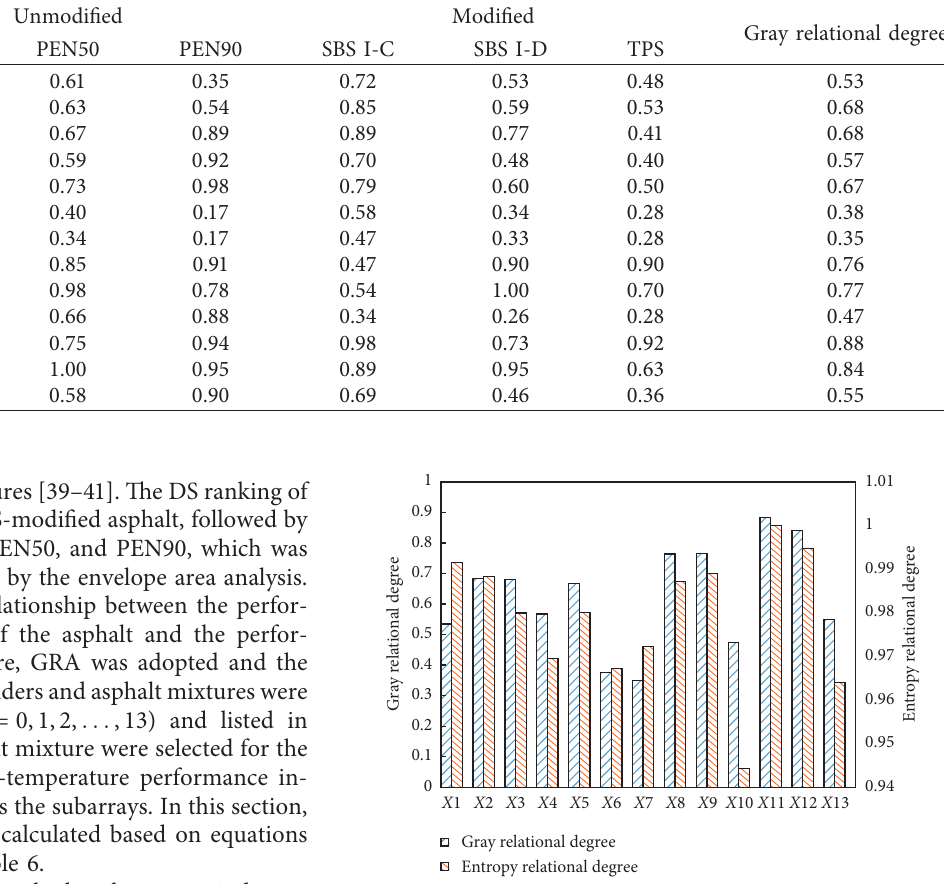
Table 7: Gray relational coefficients between asphalt indexes and dynamic stability.